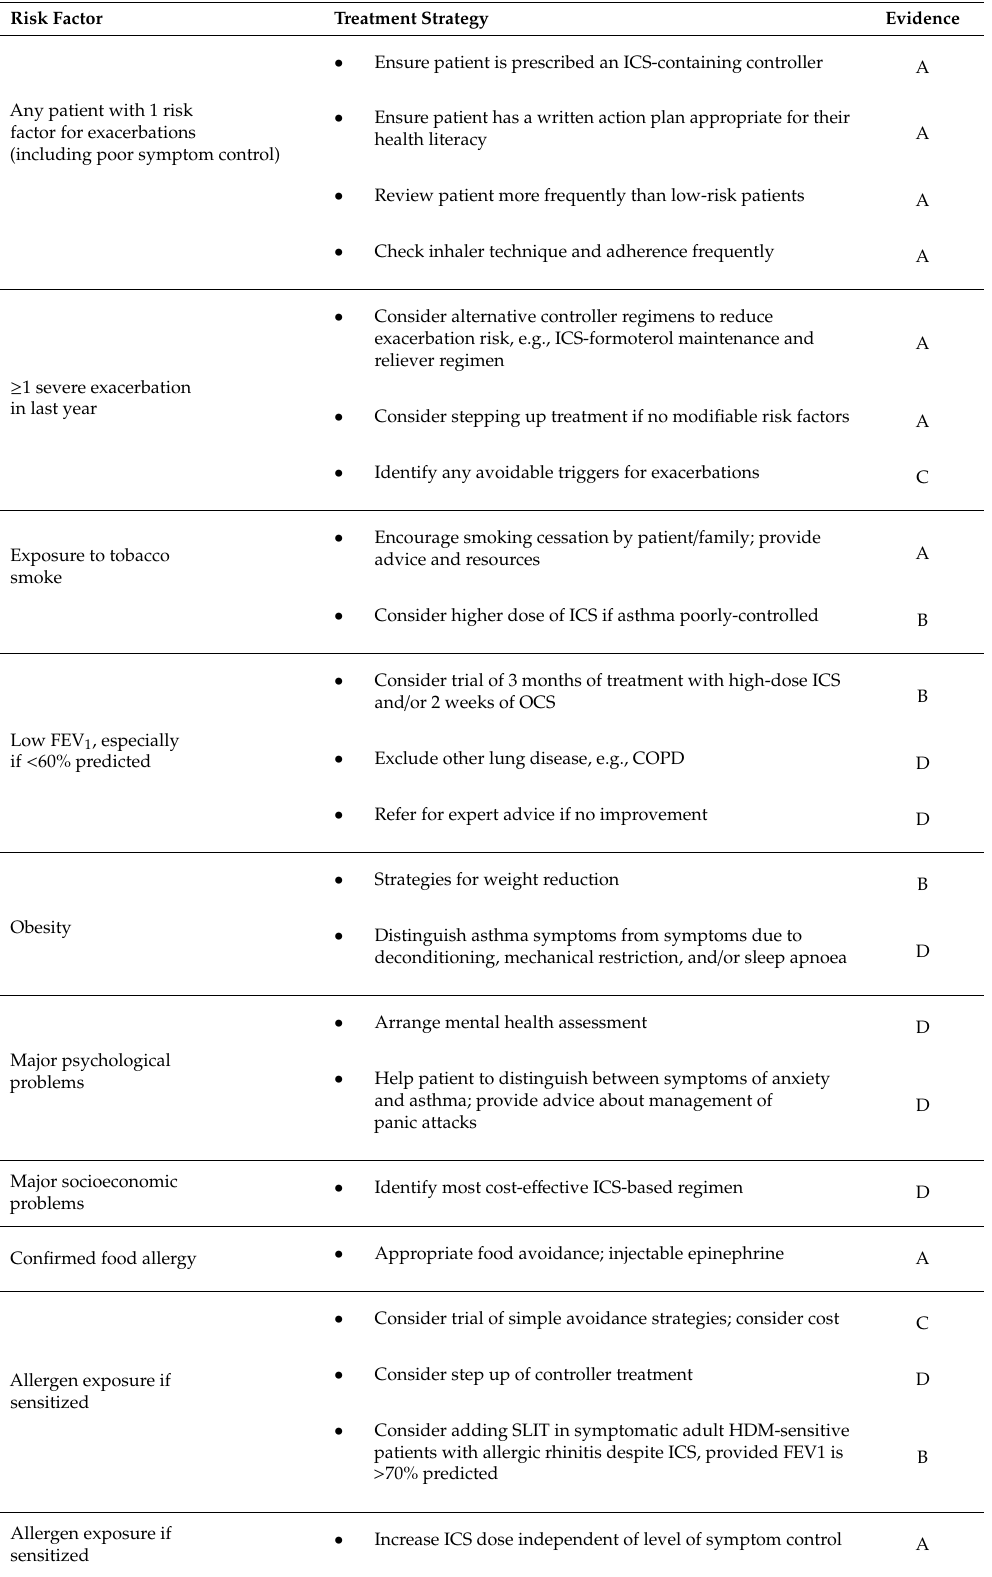
Table 5. Modifiable risk factors that have to be treated in order to reduce exacerbations. Risk Factor Treatment